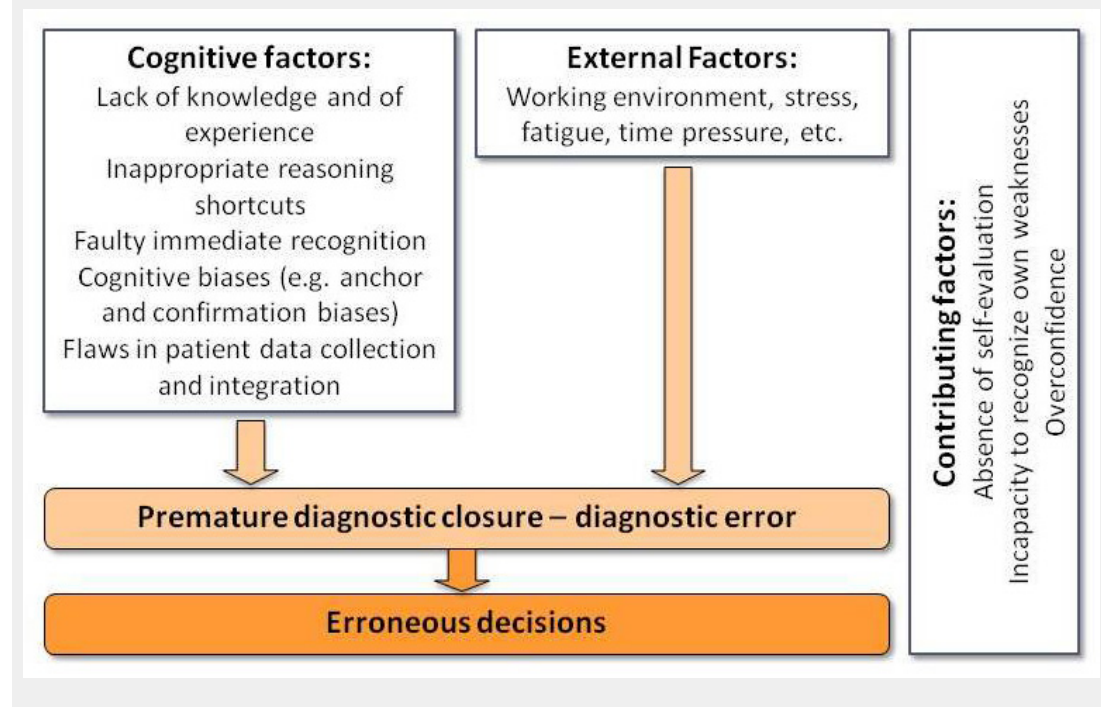
Figure 2 Cumulative conditions conducting to diagnostic and decision